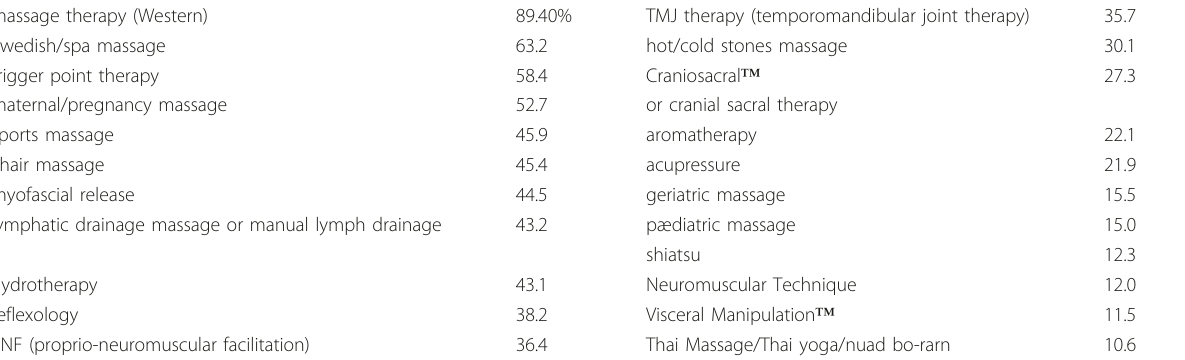
Table 3 TMBs identified during the project practiced by 10% or more of respondents massage therapy (Western)